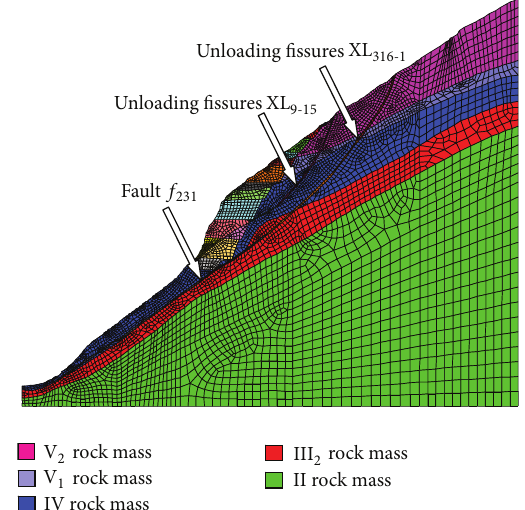
Figure 9: Numerical model of section IX-IX of the right bank slope.